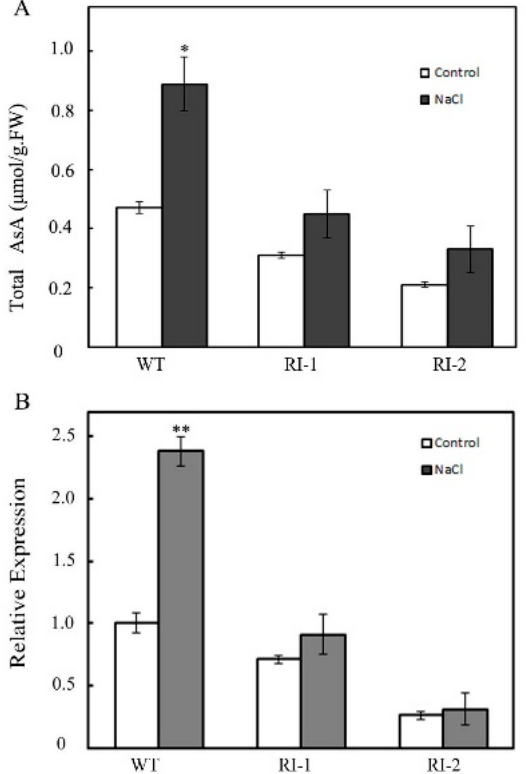
Figure 5. OsVTC1-3 regulates AsA synthesis in rice root under salt stress. ( A ) The transcript level of OsVTC1-3 in WT and OsVTC1-3 RI plants under salt stress. Control indicates that plants were grown under normal conditions, and NaCl indicates that plants were treated with 150 mM NaCl for 12 h. ( B ) The AsA content of OsVTC1-3 RI plants under salt stress. Control indicates that plants were grown under normal conditions, and NaCl indicates that plants were treated with 150 mM NaCl for five days. The bars represent SE ( ± ) of three independent assays, and the asterisk indicates results significantly different from that of the normal condition (** p < 0.01 and * p < 0.05). Significance was evaluated by the t -test.